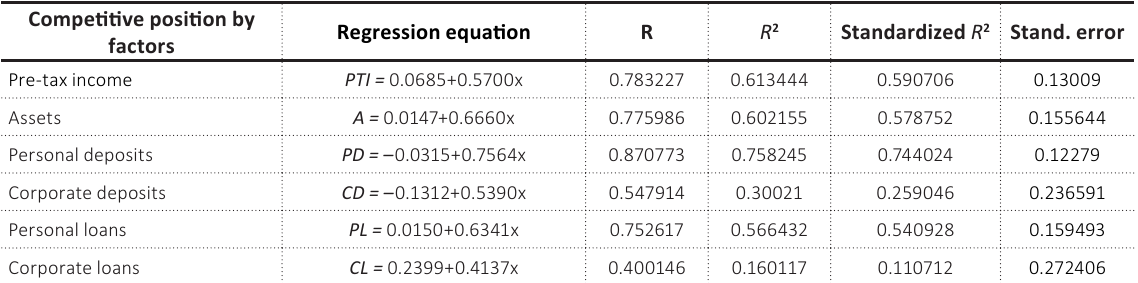
Standardized R 2 Stand.